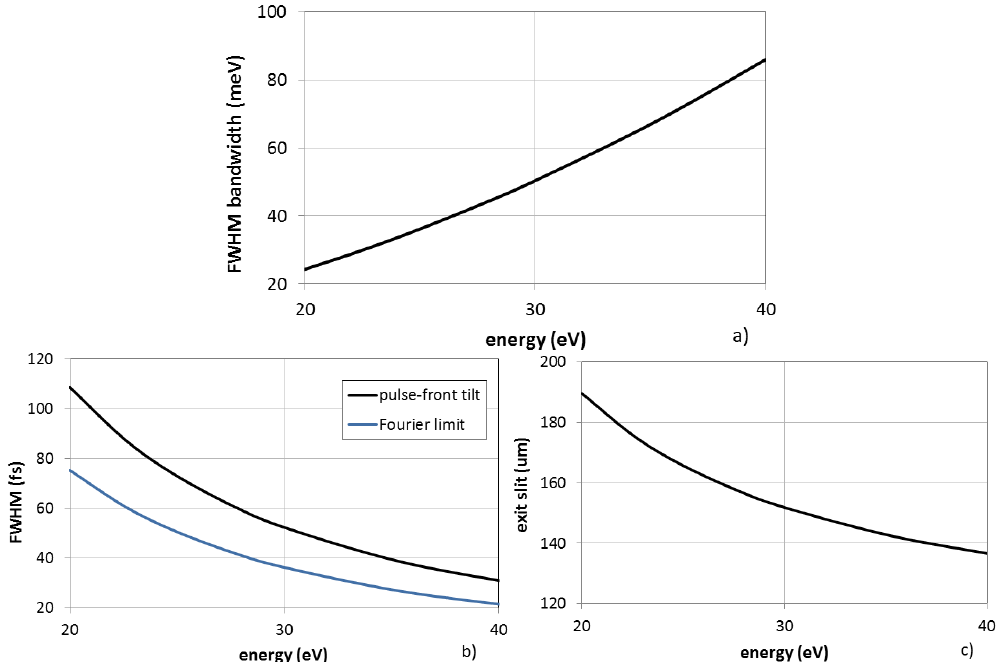
Figure 3. CDM ultrafast monochromator with a Gaussian diffraction-limited input source, 100 μm full size. The grating parameters are reported in Table 1. ( a ) Output energy bandwidth; ( b ) Temporal response of the monochromator: pulse-front tilt and Fourier limit; ( c ) Width of the exit slit to match